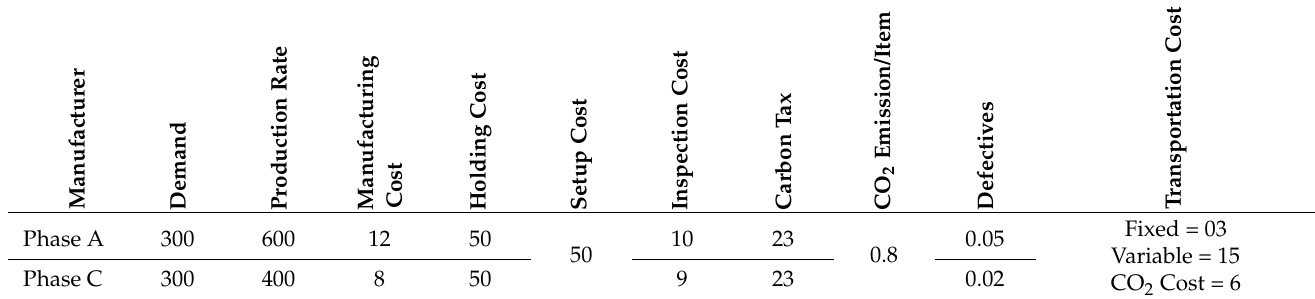
Table 3. Manufacturing data for Phase A and Phase C (automobile spare part manufacturing industry).